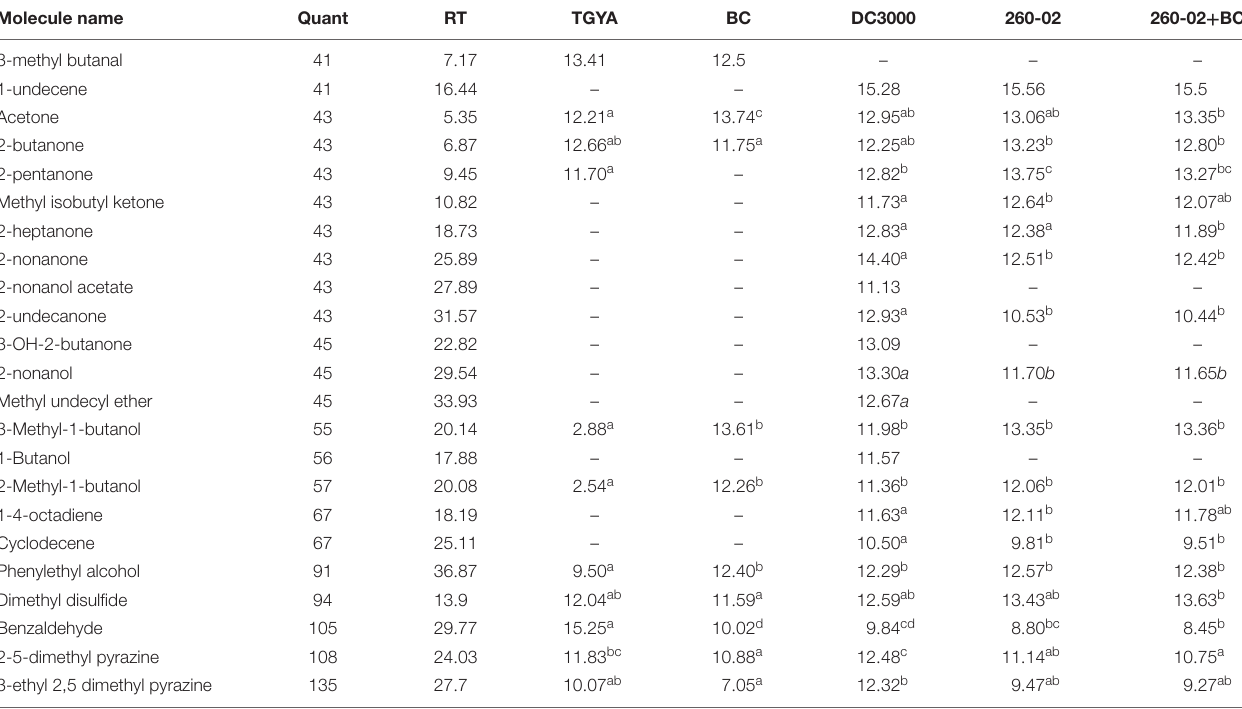
TABLE 2 | List of volatile molecules produced by the TGYA medium without inoculation, BC, strain DC3000, strain 260-02 and strain 260-02 in presence of BC, as detected through